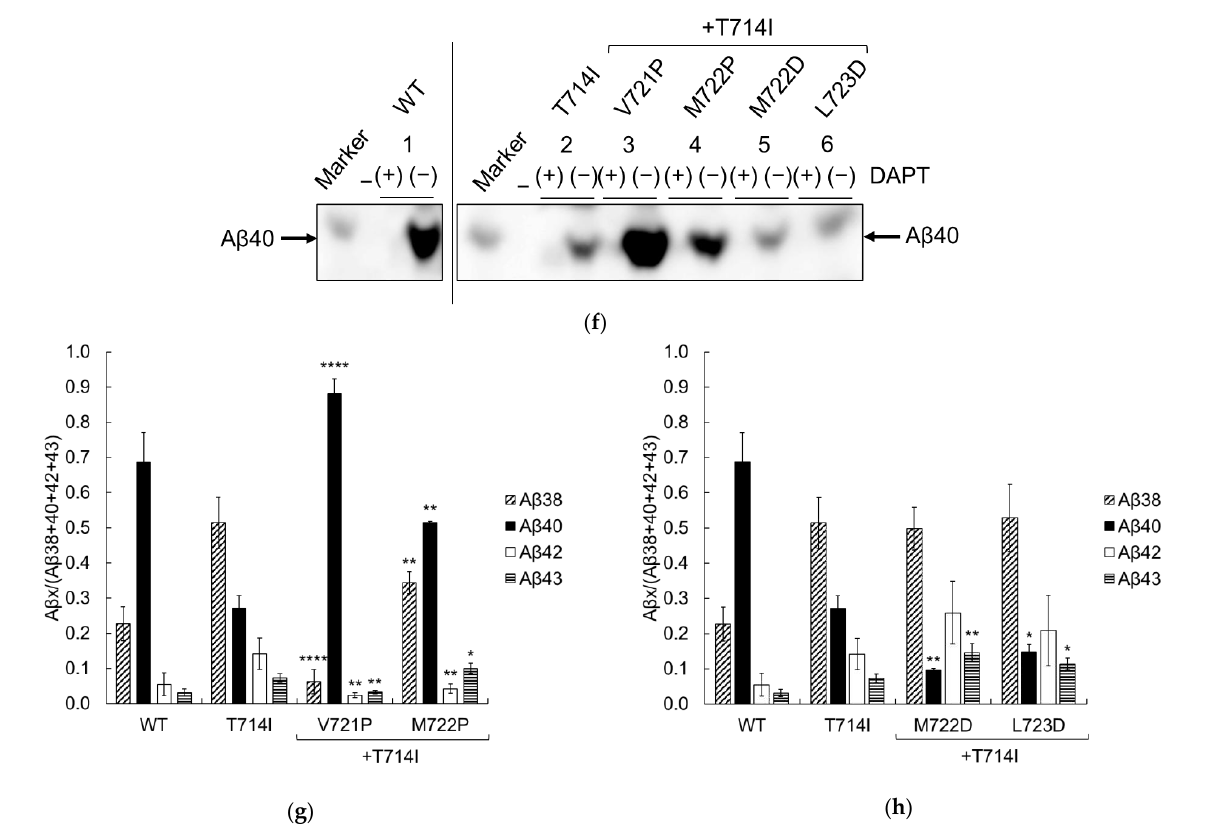
Figure 7. Aβ production in Chinese hamster ovary (CHO) cells containing APP secondary mutations and T714I. CHO cells were transfected by lipofection with WT or mutant APPC99, and an empty vector. ( a ) Secreted Aβ in the media and APP C99 in cell lysates were detected using 82E1. We also detected α-tubulin using a DM1A antibody; ( b ) The cleavage rate (Aβ/C99) was quantified form immunoblots; ( c , d ) Aβ secreted from the recovered media was quantified using two-site ELISA with antibodies against Aβ40 (left panel) and Aβ42 (right panel). For quantification, each value was sub- tracted from the vector control (349 pM for Aβ40 and 10 pM for Aβ42); ( e , f ) The recovered media were also assessed using urea/SDS-PAGE analysis at pH 8.45 ( e ) or pH8.65 ( f ) and secreted Aβ was detected using 82E1. Aβ38, Aβ40, Aβ42, and Aβ43 peptides (Peptide Institute, Japan) were loaded as controls. Each mutant was controlled by adding 10 µM DAPT, which is a γ-secretase inhibitor. An asterisk denotes nonspecific bands. Numbers 1-6 denotes lane numbers; ( g , h ) The proportions of the Aβ fragments Aβ38 (diagonal striped), Aβ40 (black), Aβ42 (white), and Aβ43 (horizontal striped) were quantified from immunoblots. All quantifications were conducted using three inde- pendent assays and are shown with standard deviations. Asterisks indicate p < 0.0001 (****), p < 0.001 (***), p < 0.01 (**), or p < 0.05 (*) compared to T714I. Aβ40 and Aβ42 were quantified using two-site ELISA. The T714I mutant secreted less Aβ40 (Figure 7c, left panel) and similar amounts of Aβ42 compared to the WT cells (Figure 7c, right panel). These results were consistent with previous reports of APP FAD mutants [15–18,29,30]. The effects of secondary mutations varied between proline and as- partate. Proline mutations (V721P and M722P) increased Aβ40 levels but reduced the amounts of Aβ42 with respect to T714I (Figure 7c). Aspartate mutations (M722D and L723D) did not alter the amounts of Aβ40 or Aβ42 relative to T714I (Figure 7d). These results imply that proline mutations restored the trimming activity and reduced long Aβ42, while aspartate mutations did not. For more detailed discussion, it became neces- sary to analyze all secreted Aβ species, including short Aβs.